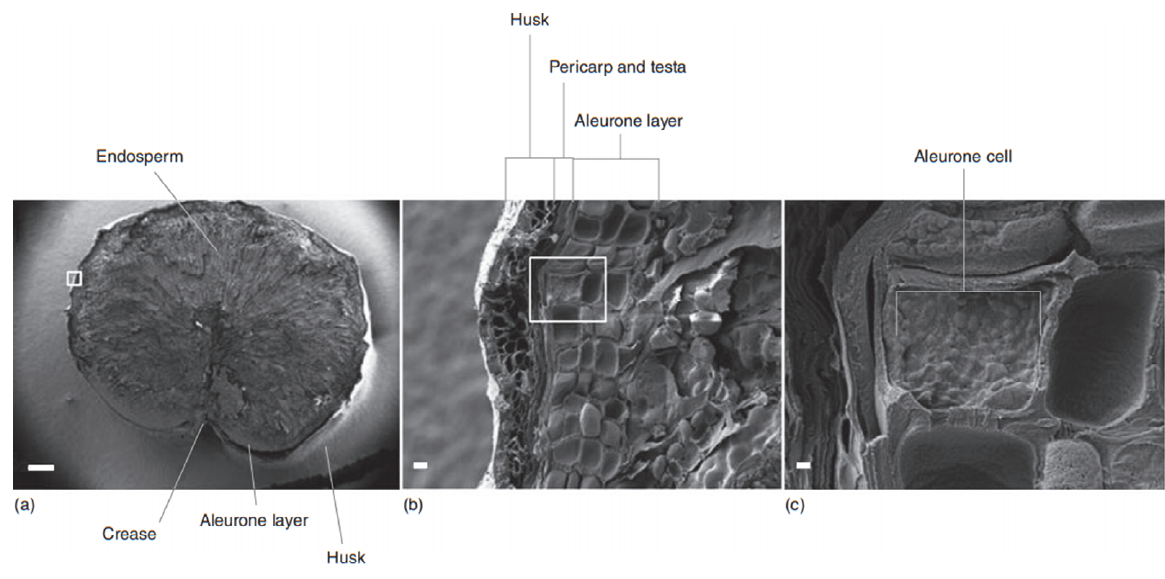
Figure 1. Structure of the barley kernel sectioned transversely ( a ) with detailed husk ( b ) and starchy endosperm ( c ), Reprinted with permission from ref. [9]. Copyright 2013 Elsevier.